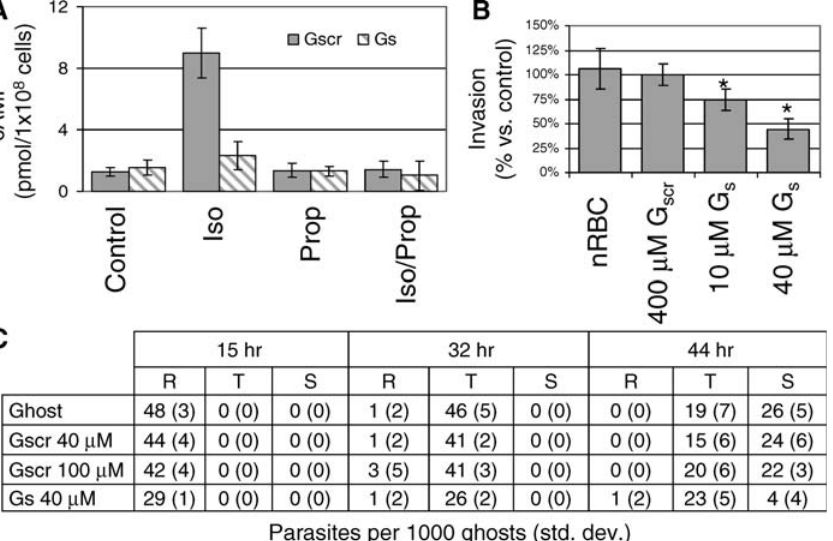
Figure 4. Targeting Erythrocyte G s Down-Regulates b -Adrenergic Signaling and Inhibits Malarial Infection (A) Ghosts incubated in 40 l M G s (indicated by hatched bars) or G scr control peptide (indicated by solid bars) were treated with agonist (isoproterenol [iso]) and/or antagonist (propranolol [prop]), and cAMP was measured as described in Methods. Error bars show 95% CI of triplicate measurements from a representative experiment of three independent experiments. The mean baseline cAMP concentration in control ghosts was 1.08 pmol cAMP (95% CI 0.57–1.60 pmol; four experiments) per 1 3 10 8 cells. The maximum isoproterenol-induced cAMP level obtained in control-treated ghosts was 12.45 pmol cAMP (95% CI 10.20–14.70 pmol) per 1 3 10 8 cells. (B) Ghosts incubated with G s peptide ( (cid:1) 40 l M) or G scr control peptide (up to 400 l M) were assayed for malarial invasion. Data are represented as percentage inhibition relative to control cultures treated with equimolar concentrations of control peptide. Three experiments in triplicate for each data point except 10 l M (two experiments in triplicate). Error bars show 95% CI for all experiments; asterisks indicate p , 0.001 compared to 400 l M control G scr peptide–treated cultures. (C) Parasites in ghosts were incubated with the indicated concentrations of peptide and monitored at 15, 32, and 44 h after invasion by examination of Giemsa-stained thin blood smears. The number of ring (R)–, trophozoite (T)–, and schizont (S)–stage parasites per 1,000 total ghosts at each time point are shown; numbers in parentheses indicate the standard deviation of triplicate measurements from one experiment; a total of two experiments were carried